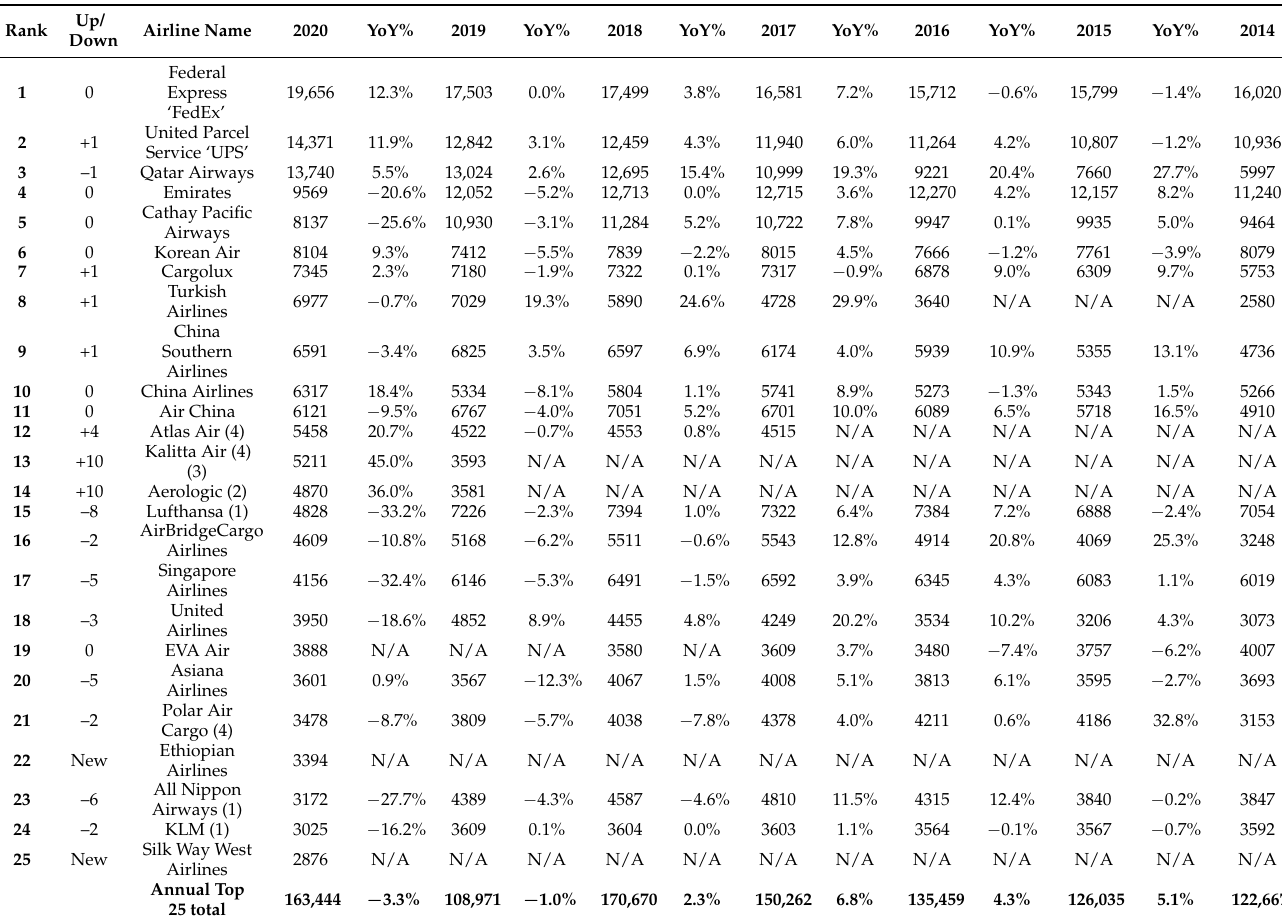
Table 3. Top 25 cargo airlines worldwide from 2020 to 2014 (Scheduled Cargo Tonne Km ‘CTK’ terms, and International + Domestic flight), and Year-on-Year